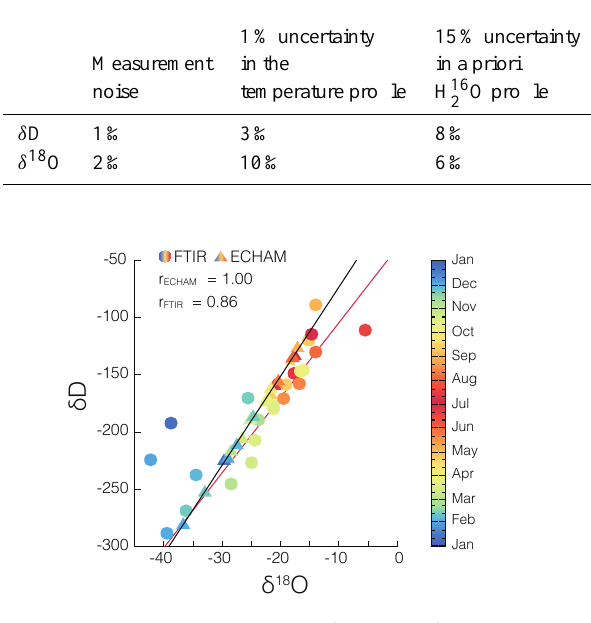
Figure 10. Scatter plot of the retrieved (colour dots) and simulated by the ECHAM5-wiso GCM (colour triangles) columnar values of δ 18 O and δ D. Black line: linear regression of the model data. Red line: linear regression of the FTIR retrievals.